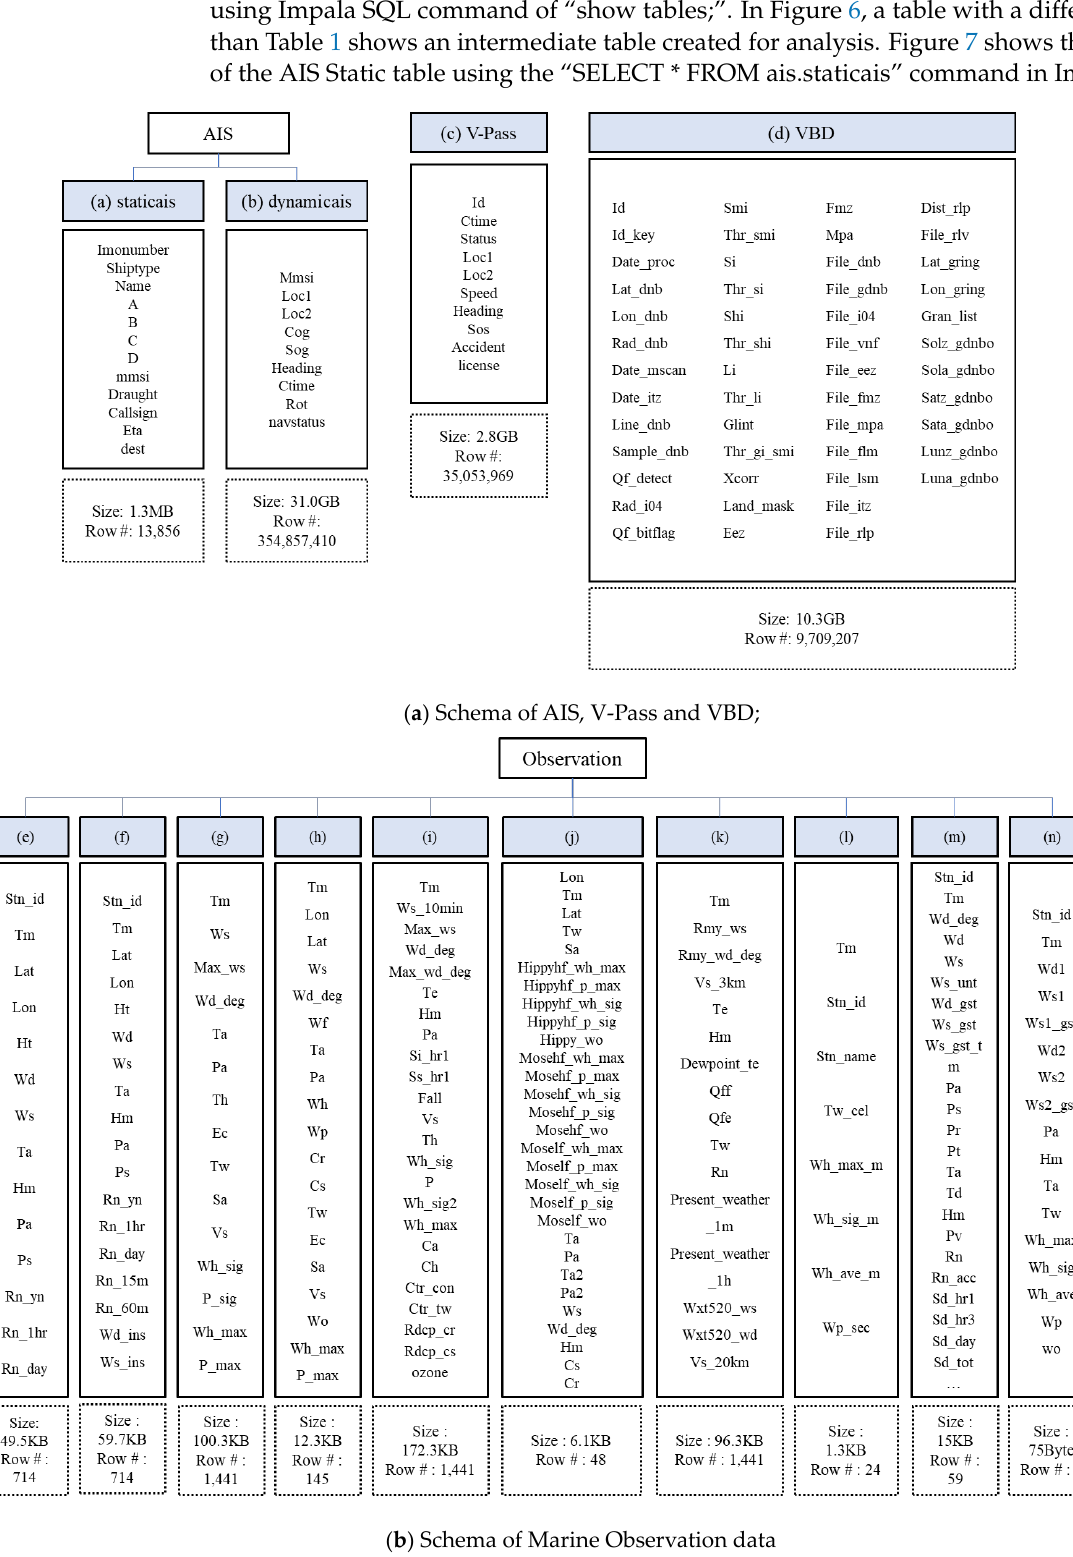
Figure 4. Data Lakehouse schema for AIS, V-Pass, VBD, and Observation data.